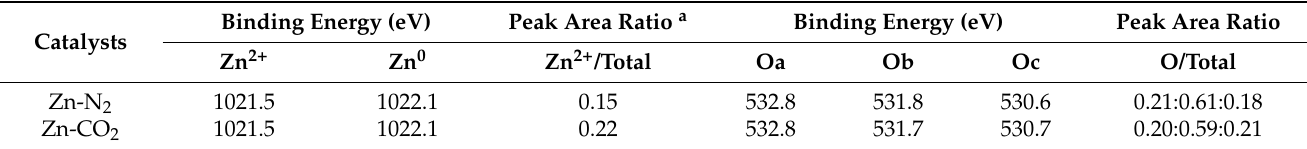
Figure 6. XPS spectra of ( a ) overall survey scan, ( b ) Zn 2P, ( c ) Zn 2P 3/2 , ( d ) O 1s for the Zn-N 2 and Zn-CO 2 electrodes. Table 1. X-ray photoelectron spectroscopy (XPS) characteristics data of Zn 2P 3/2 and O 1s regions for the Zn-N 2 and Zn-CO 2 electrodes.